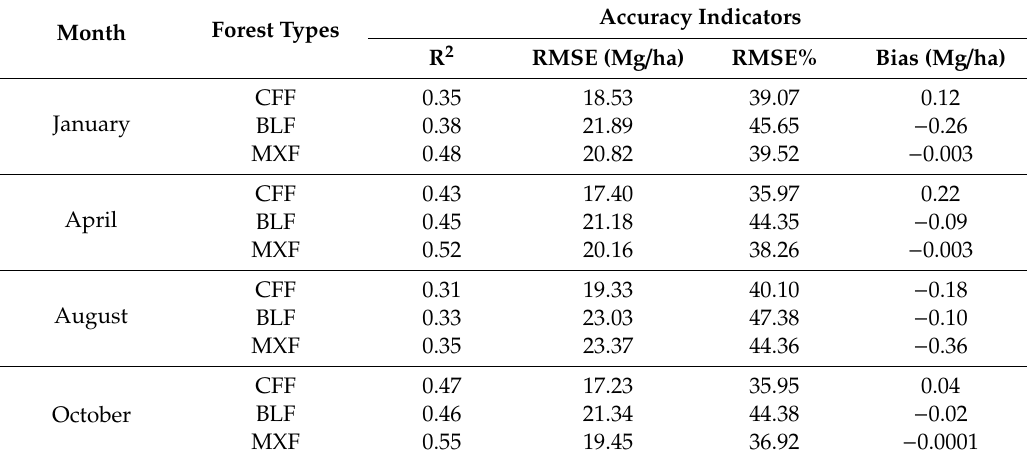
Table 8. Summary of the accuracy assessment results for the seasonal models based on di ff erent forest